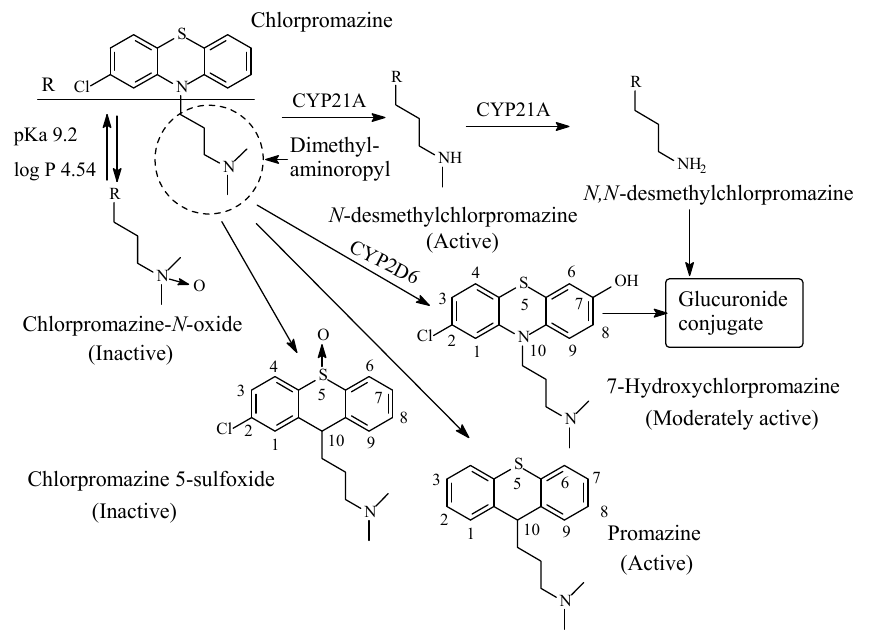
Figure 20. Major metabolic pathways of chlorpromazine.